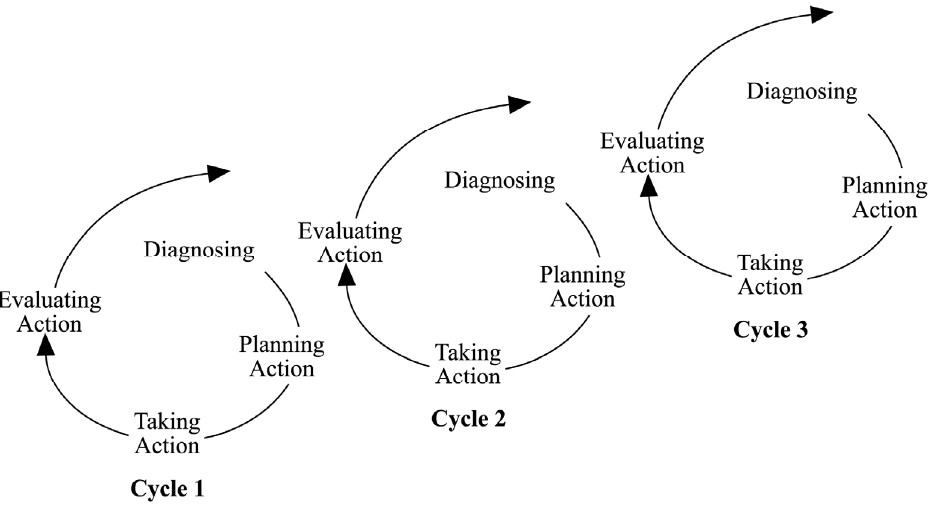
Figure 1. The continuous cycles of Action Research (source: